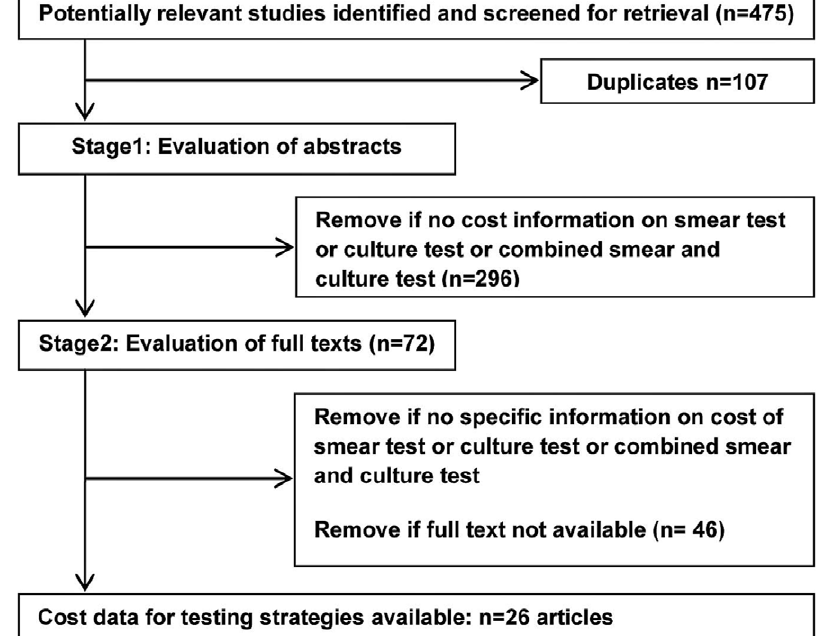
Figure 1. Study selection procedure for peer-reviewed literature from 1995–2012.